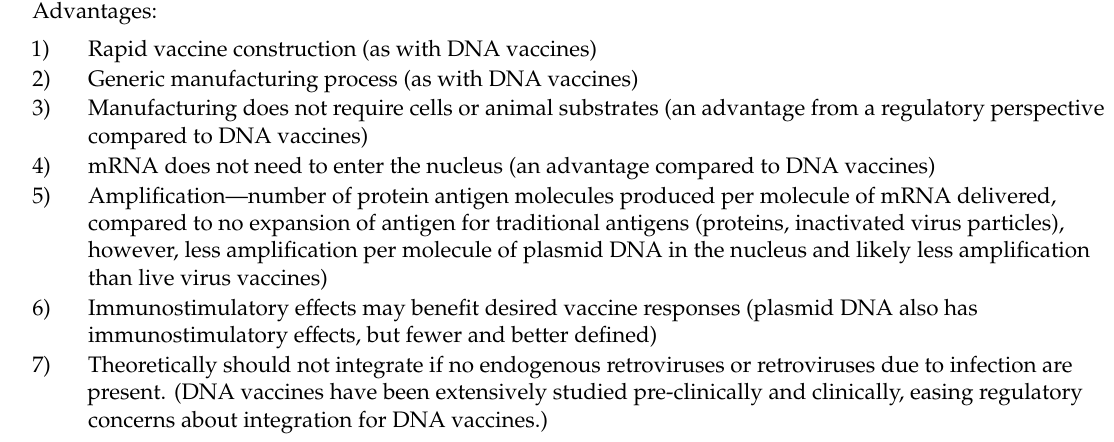
Table 5. Advantages and Disadvantages of mRNA Vaccines (and comparison to DNA